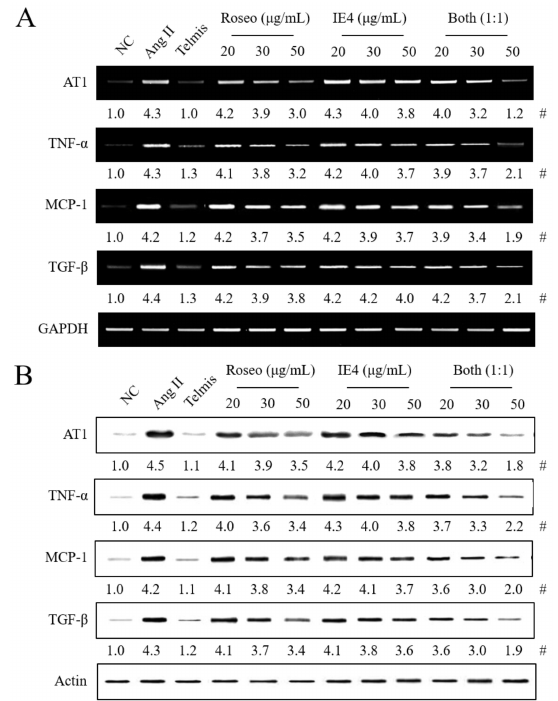
Figure 3. Effects of roseoside and icariside E4, alone or in combination, on the expression of hypertension-related molecules in the Ang II-stimulated H9C2 cells. The experimental details of the stimulation of H9C2 cells and their treatment with different compounds were described in Figure 1 legend. Telmis (10 µ M), roseoside (Roseo; 20, 30, or 50 µ g/mL), icariside E4 (IE4; 20, 30, or 50 µ g/mL), and Roseo/E4 combinations (20, 30, or 50 µ g/mL, 1:1 ratio) were administered 1 h before Ang II stimulation. The expression of all hypertension-related molecules was determined in mRNA or protein extracts isolated from H9C2 cells using RT-PCR and Western blot, respectively. ( A ) Expression of all hypertension-related molecules’ mRNA. ( B ) Protein expression of all hypertension-related molecules. Both, combination of Roseo and IE4 (1:1 ratio; each component used at a dose of 10, 15, 25 µ g/mL; total doses for the different mixtures at a 1:1 ratio were 20, 30, 50 µ g/mL). Ang II, angiotensin II stimulation. #, Numbers below the band images indicate the mean values ( n = 4) obtained as described in Figure 1